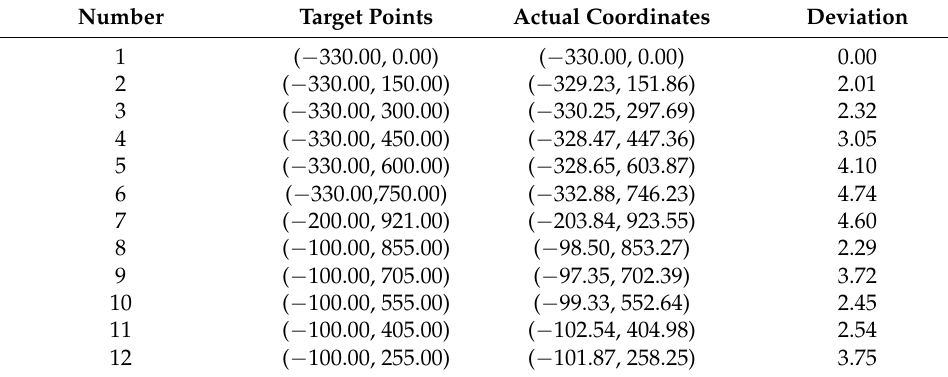
Table 3. “U” path cruise test data Unit: cm.